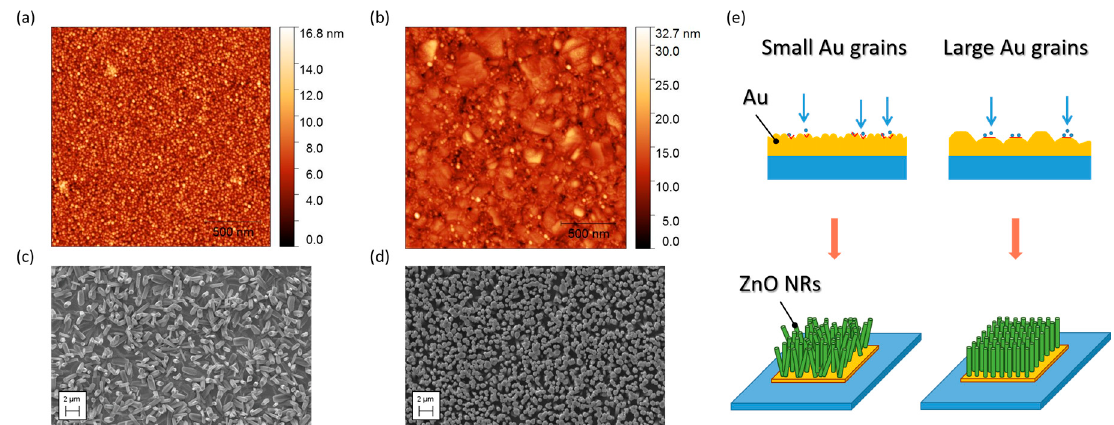
Figure 3. AFM images of Au deposited on Si substrates ( a ) before and ( b ) after annealing at 300 °C for 15 minutes. SEM images of ZnO NRs grown on substrates, ( c ) untreated and ( d ) annealed at 300 °C for 15 min. ( e ) Schematic representation of NRs nucleation and growth mechanisms occurring predominantly from the boundaries of small Au grains, and from the surfaces of large Au grains.